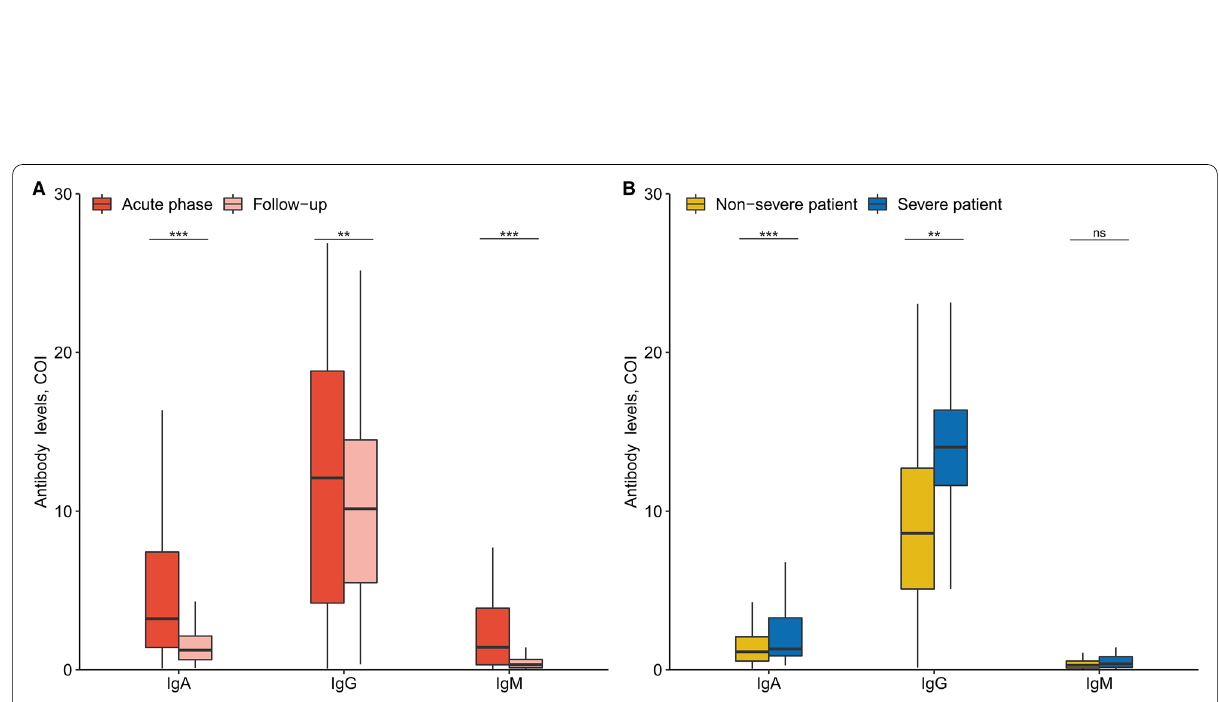
Fig. 5 SARS-CoV-2 RBD-specific antibody levels in recovery patients with COVID-19. A Levels of anti-RBD IgA, IgG, and IgM antibodies in 163 recovery patients at acute phase and 1-year follow-up. The difference was determined by the paired samples Wilcoxon test. B Levels of anti-RBD IgA, IgG, and IgM between 173 non-severe patients and 49 severe patients at 1-year follow-up. The difference between two groups was determined by the Wilcoxon test. COI, cut-off Index. ns, P > 0.05; **, P 0.01; ***, P ≤ ≤